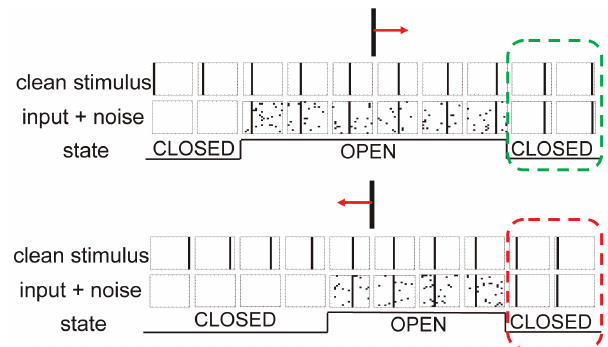
Figure 5. Pattern completion in the context of moving bars across a visual field. A 400 neuron network arranged in a 20 6 20 sheet with topographic input from the visual field is trained on bars moving left, right, up and down (See Figure S4 for details). The network carries out pattern completion in response to bars moving right (top) and left (bottom). The clean input is presented with equal power random noise during the open state. The network performs perfect pattern completion during the second closed state (dashed boxes) following the presentation of a long-enough sequence of moving bars during the preceding open state. Open/closed durations are sampled from a Gaussian with a mean of 7 and sd of 2 time steps. For the sake of space, bars moving up and down are omitted and only every other time-point is shown.